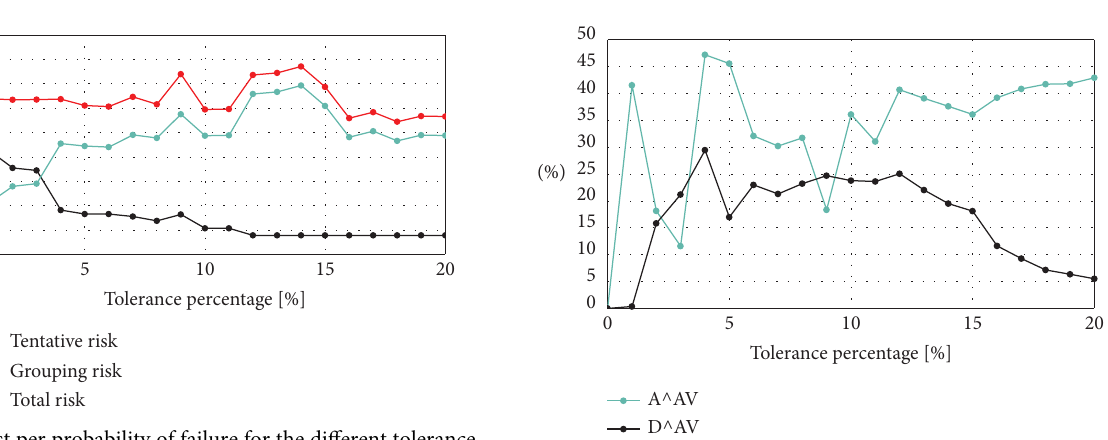
Figure 10: Evolution of the performance indicators of the use of tolerance of delayed or delayed activities.